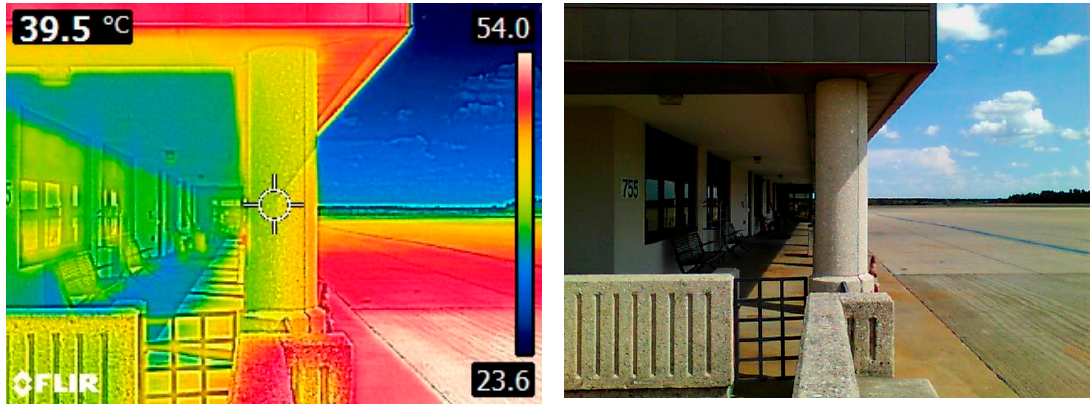
Figure 4. Airport building with shaded verandah and surface thermal properties. COMFA Energy Budget = +133 W/m 2 (thermally comfortable and safe).